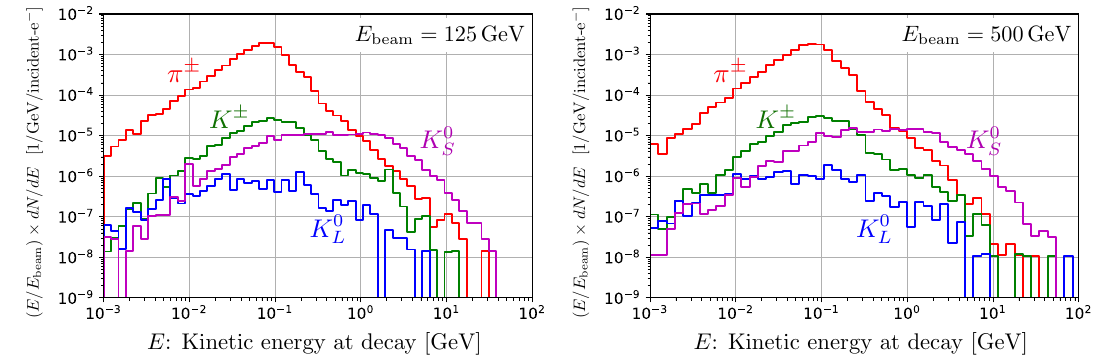
Figure 2 . The kinetic energy distribution of light mesons when they decay, where π ± and K ± indi- cates the sum of charged pions and kaons. We consider two beam energies, E at ILC-250 and ILC-1000,